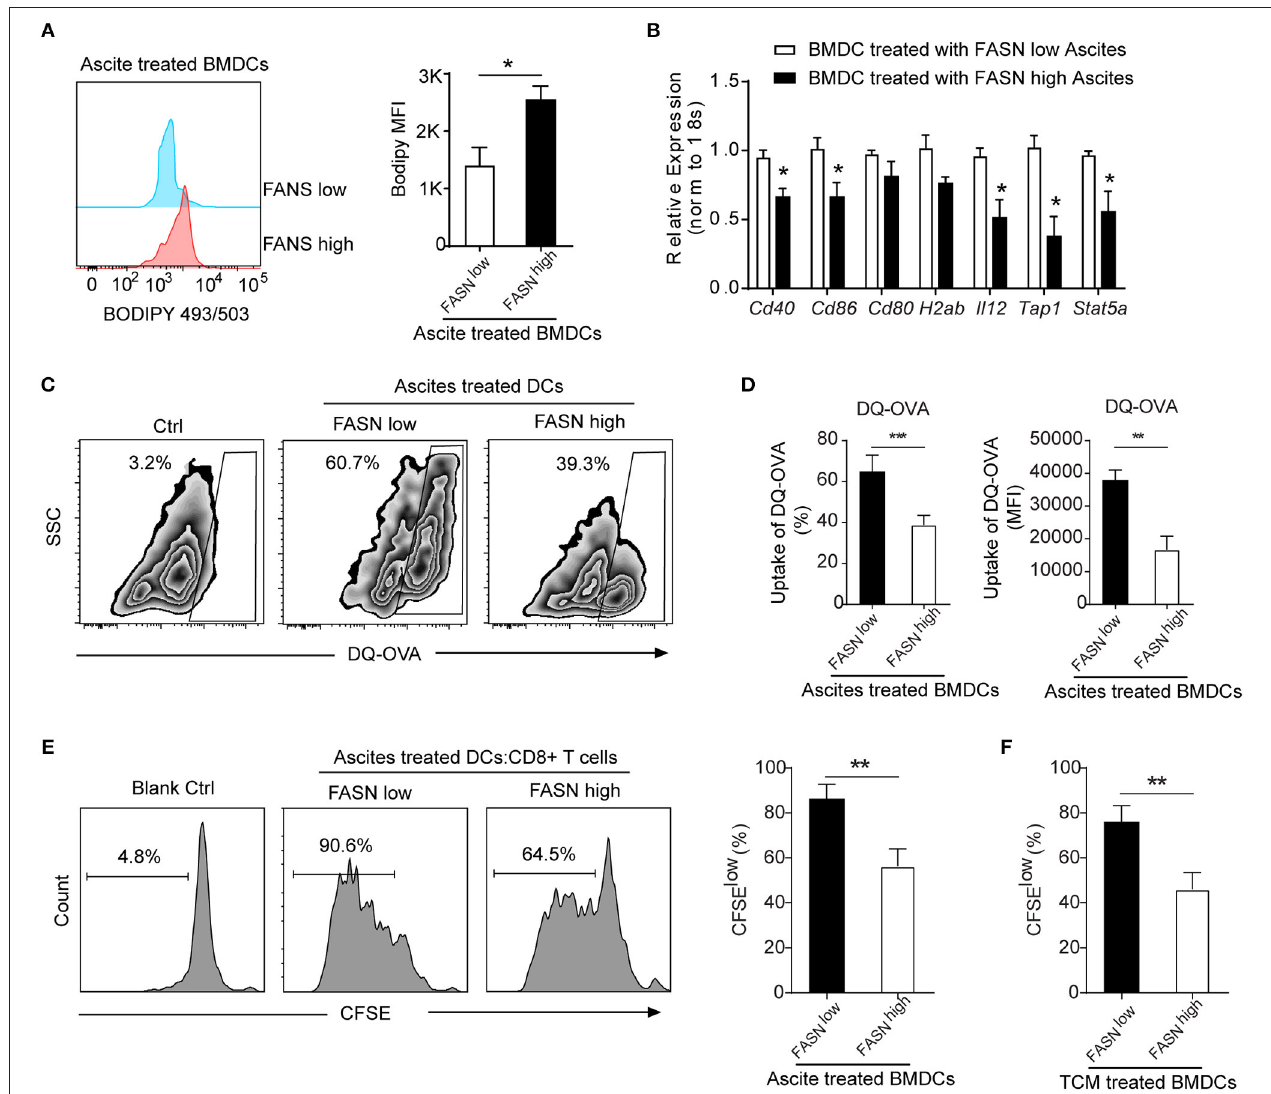
FIGURE 5 | Educated DCs by ascites exhibited defective antigen presentation and impaired priming of T cell activation. (A) Flow cytometric staining with Bodipy 493/503 in BMDCs cultured in the presence of 20% ascites harvested from FASN low or FASN high ID-8 tumor-bearing mice for 24h. MFI average is depicted. Means ± s.d. are shown. (B) mRNA expression of indicated DCs associated genes in BMDCs cultured in the presence of 20% ascites harvested from FASN low or FASN high ID-8 tumor-bearing mice. The results were normalized to the level of expression of 18sRNA. (C,D) Uptake of DQ-OVA by BMDCs in the presence of 20% ascites harvested from FASN low or FASN high ID-8 tumor-bearing mice. Quantification of uptaking DQ-OVA was shown. Means ± s.d. of three mice per group are shown. (E, F) In vitro immunostimulatory activity of BMDCs treated with ascites (E) or TCM (F) harvested from FASN low or FASN high ID8 tumor-bearing mice. Representative histograms of CD8 + T cell proliferation at CD8 + to BMDCs ratio 10:1 (left panel) and quantification of CD8 + T cell proliferation using CFSE dilution (right panel) ( n = 3). Data = mean ± SEM; representative of at least 3 independent experiments; ns, no significance; * P < 0.05; ** P < 0.01; *** P <